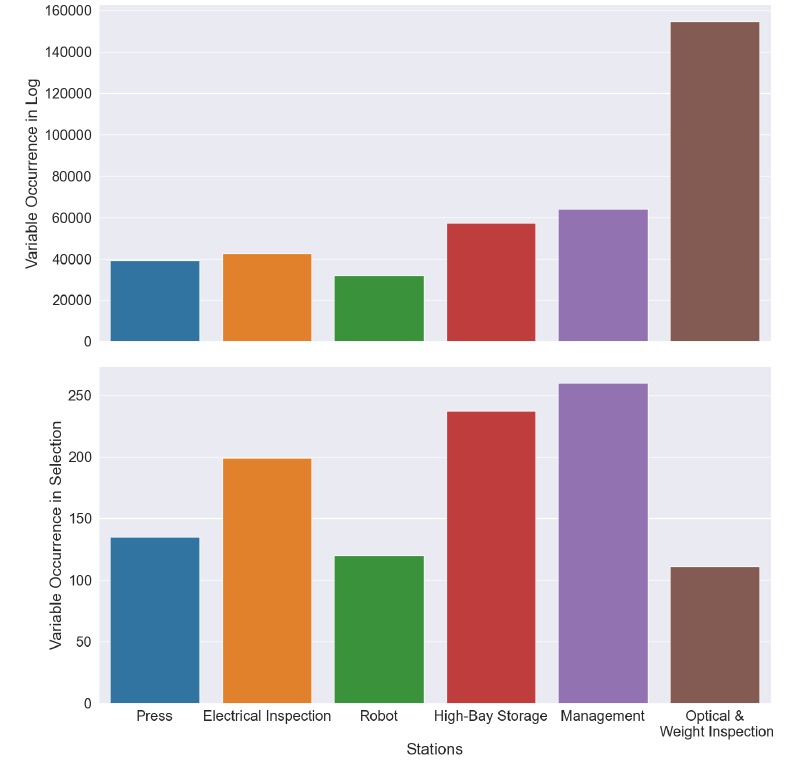
Figure 7. Number of OPC UA Variables before selection in pData ( top ) and after selection ( bottom ).